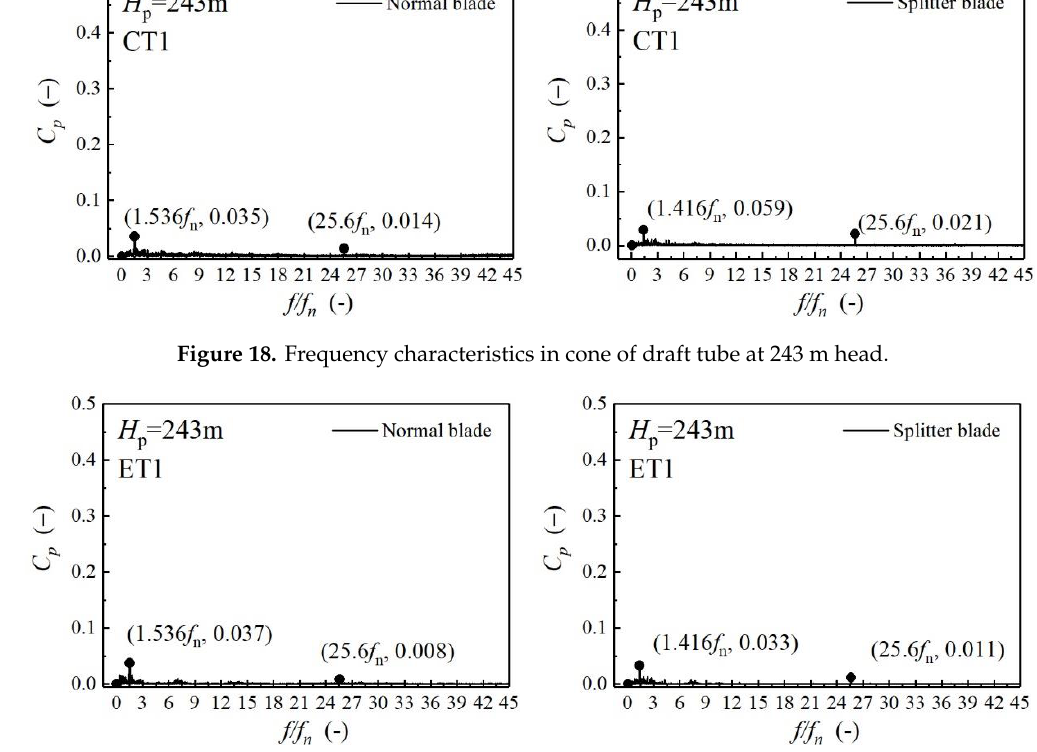
Figure 19. Frequency characteristics in elbow of draft tube at 243 m head.